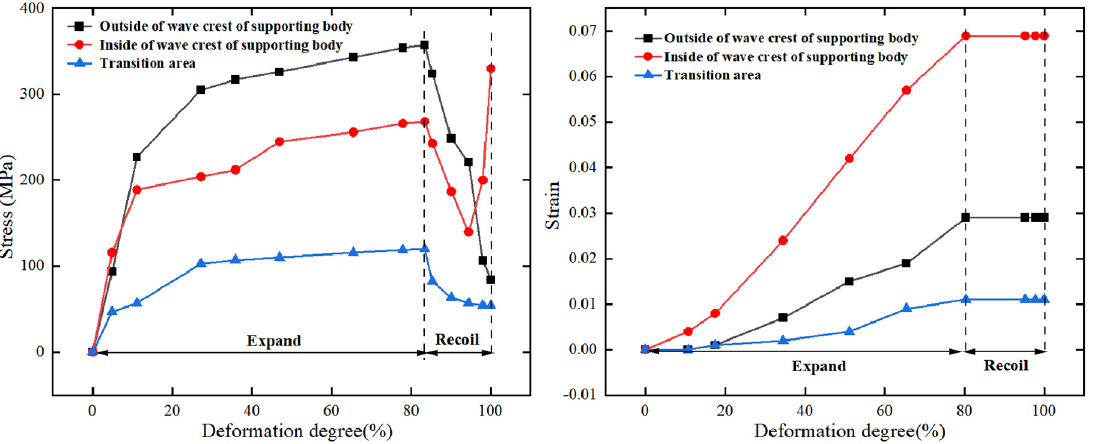
Figure 11. Variation of stress and strain at some points of L-type coronary stent during expansion stage.